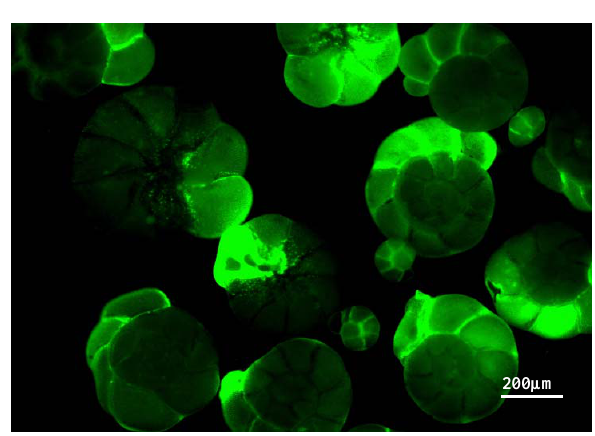
Fig. 1. Newly formed chambers are visible under fluorescent light as a result of the incorporation of